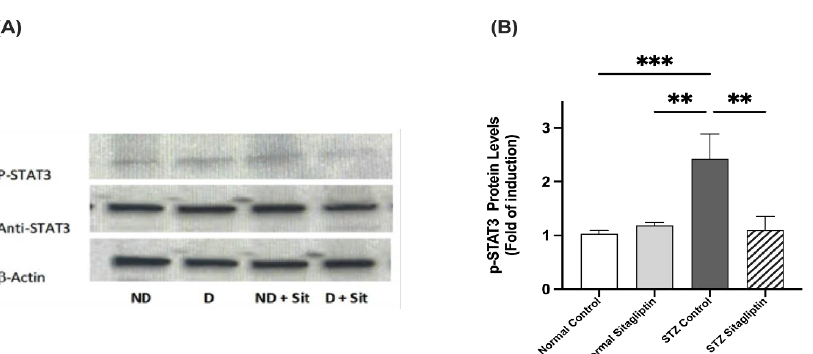
Figure 5. Effects of sitagliptin on phosphorylated signal transducer and activator of transcription (P-STAT3) expression in STZ-induced diabetic rats. ( A ) Representative images of P-JAK2 in kidney tissue homogenates; ND, normal control group; D, STZ-induced diabetic control group; ND + Sit, normal control group treated with sitagliptin; D + Sit, sitagliptin-treated diabetic group. Resolution of the proteins obtained from sample tissues was performed by using SDS-PAGE, and then the P-STAT3 antibody was used for immunoblotting, along with total STAT3 and β-actin antibodies subsequent to stripping. ( B ) ImageJ software was used to quantify the immunoblot densities. Β-Actin was used to normalize the levels of P-STAT3. The expression of quantities is indicated as fold induction relative to the group comprising normal controls. Data represent the mean ± SEM ( n = 6 samples from 6 animals per group). The one-way ANOVA test and then the Bonferroni post hoc test were used to compare groups; ** p < 0.01, *** p < 0.001.